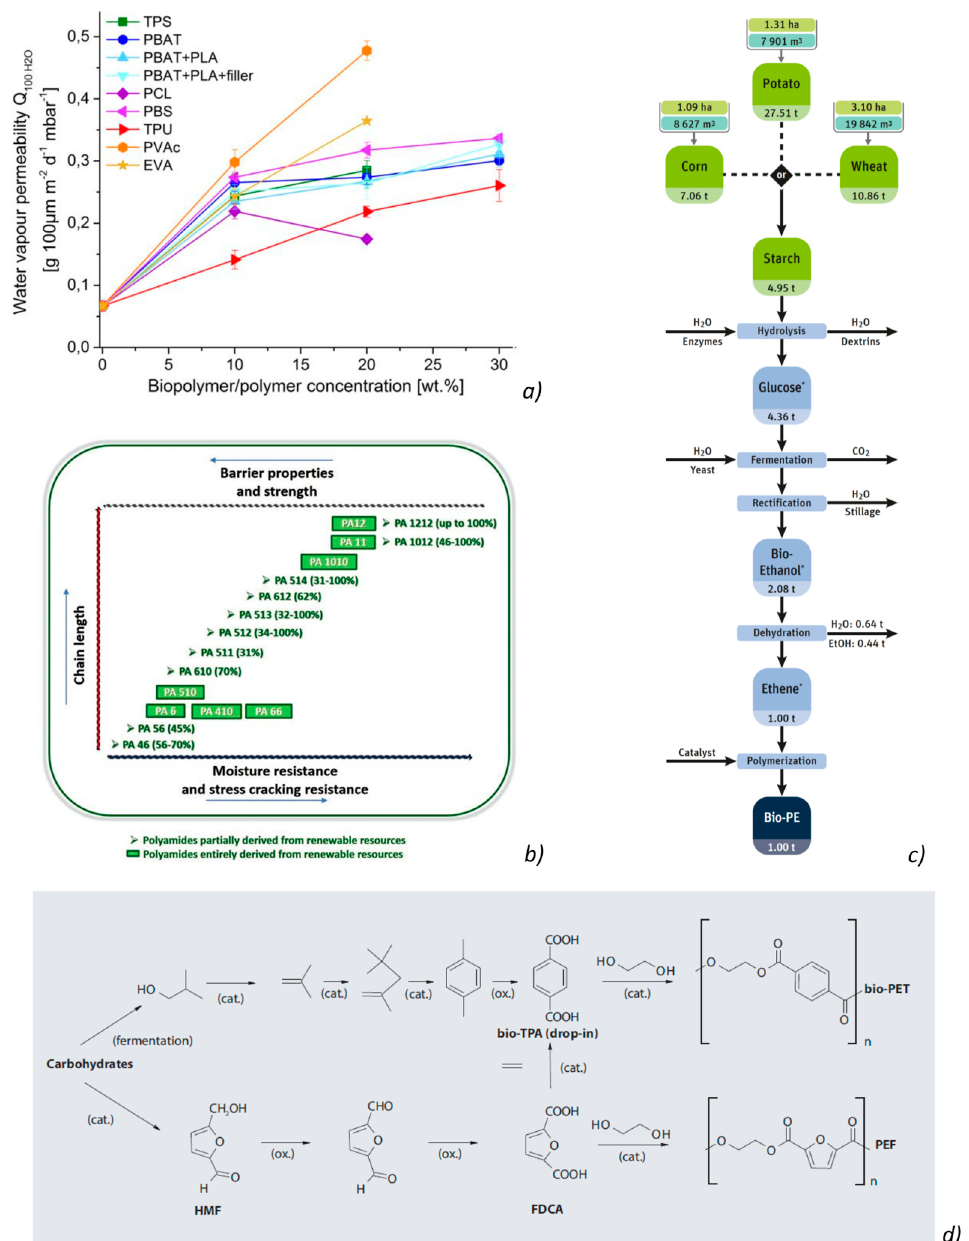
Figure 5. Water vapor permeability for Poly(3-hydroxybutyric acid-co-3-hydroxyvaleric acid) (PHBV) blended with nine different biopolymers and polymers at different concentrations ( a ) [168] ; polyamides completely and partially obtained from renewable sources ( b ) [163] ; processing route for bio-polyethylene (bio-PE) (c) [169] ; ( d ) transformation of sugar to Polyethylene 2,5- furandicarboxylate (PEF) and bio- polyethylene terephthalate (bio-PET), a new bio-based plastic similar to PET [170]